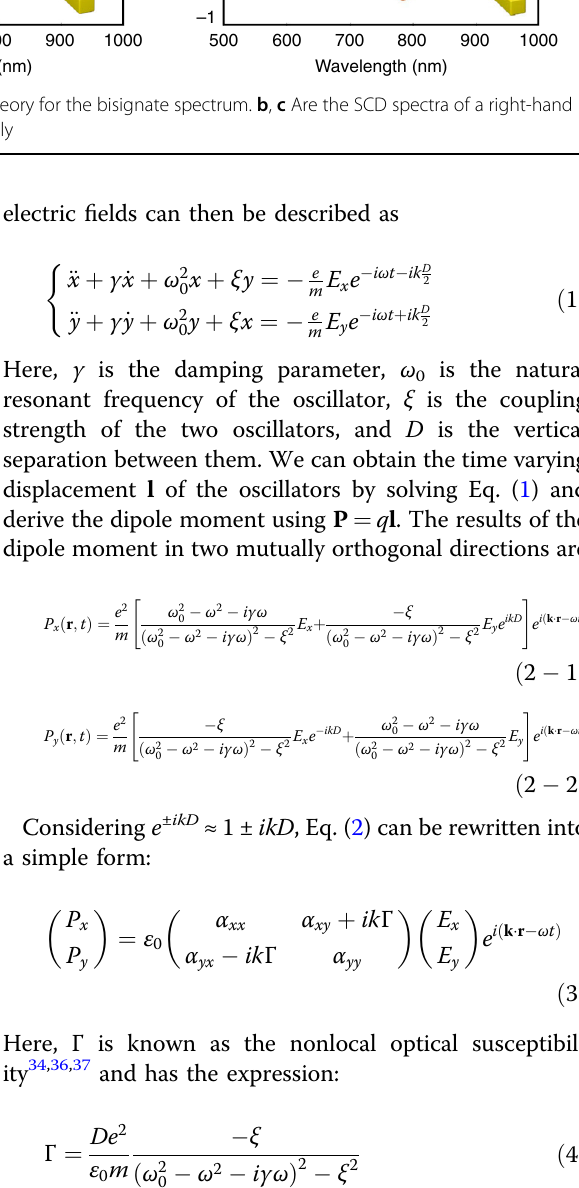
Fig. 2 Origin of the bisignate SCD spectral pro fi le. a The hybridization theory for the bisignate spectrum. b , c Are the SCD spectra of a right-hand and left-hand nanorod pair predicted by the Born – Kuhn model,